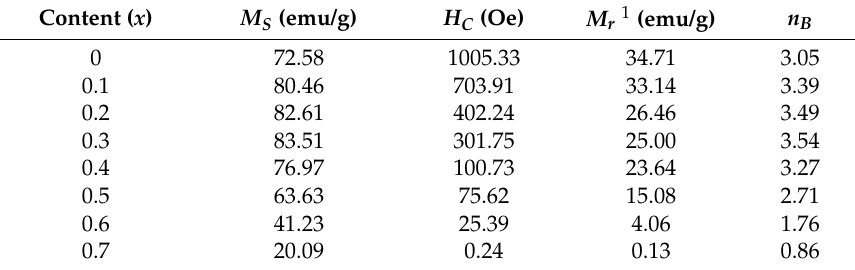
Table 5. Magnetic data for Co 1 − x Zn x Fe 2 O 4 calcined at 800 ◦